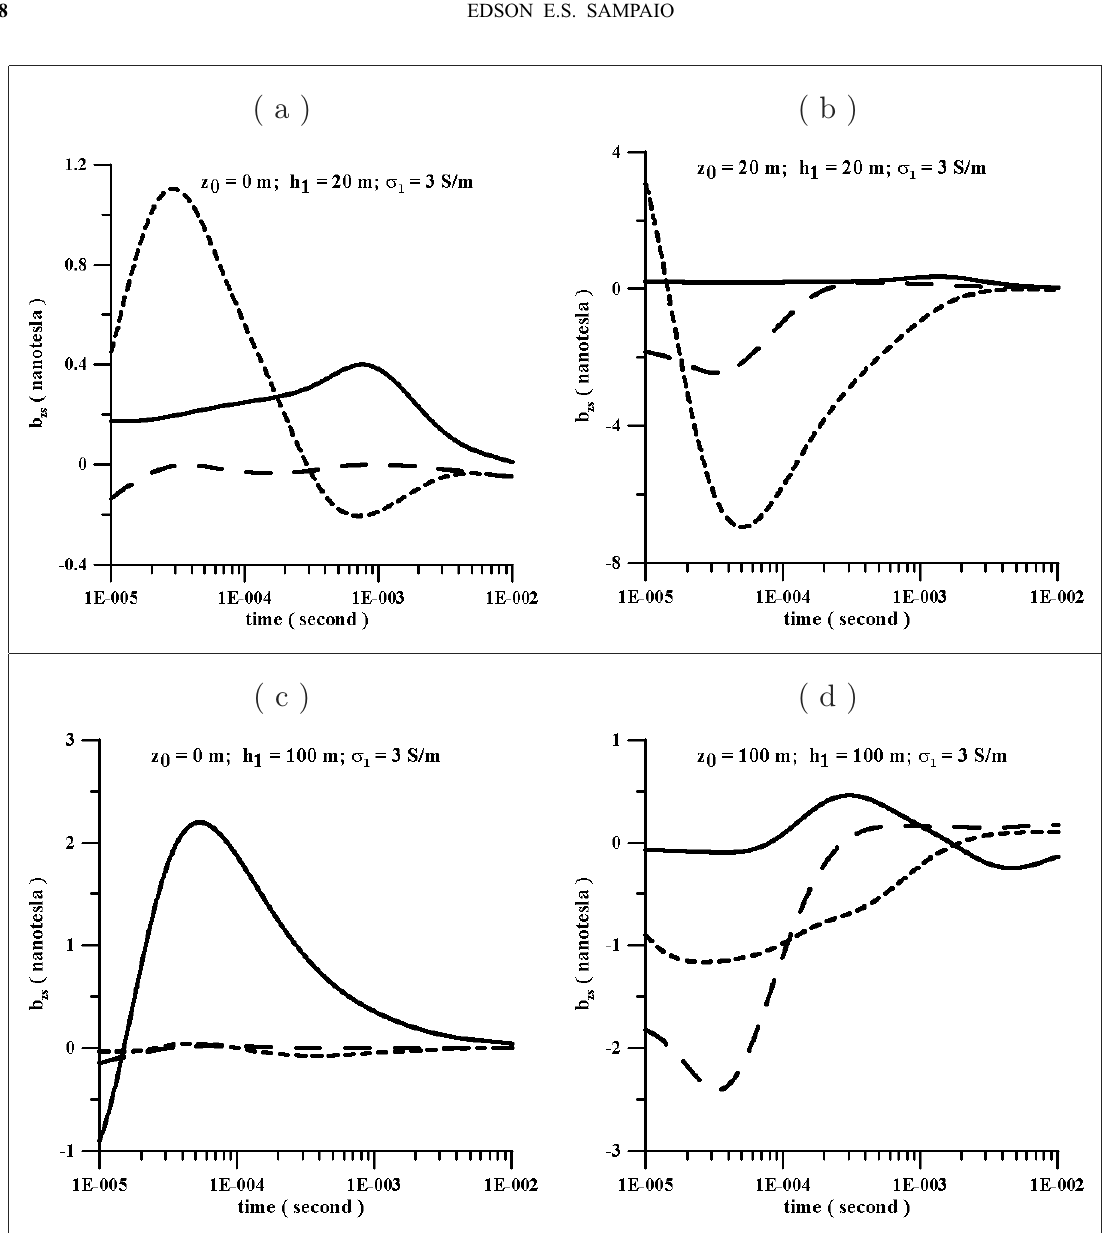
Fig. 7 – Graphs of the time variation of the main contribution of the substratum for the vertical component of the magnetic field: σ 2 represents the conductivity of the substratum. (a) and (b) h 1 = 20 m. (c) and (d) h 1 = 100 m. Solid line: Dotted line: σ 2 = 0 . 03S/m. Dashed line: σ 2 = 0 . 003